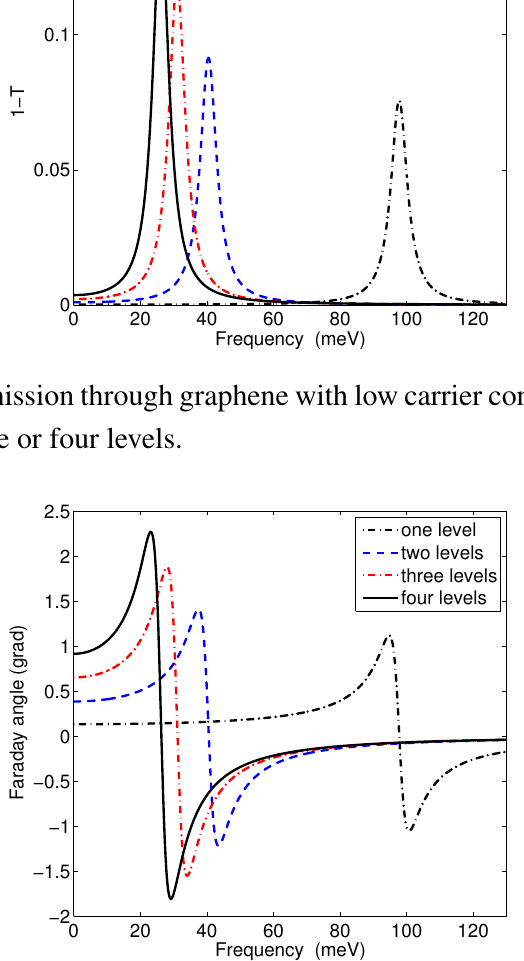
Figure 3. Faraday rotation for the cases when electrons occupy only several levels; the electron relaxation frequency Γ = 3